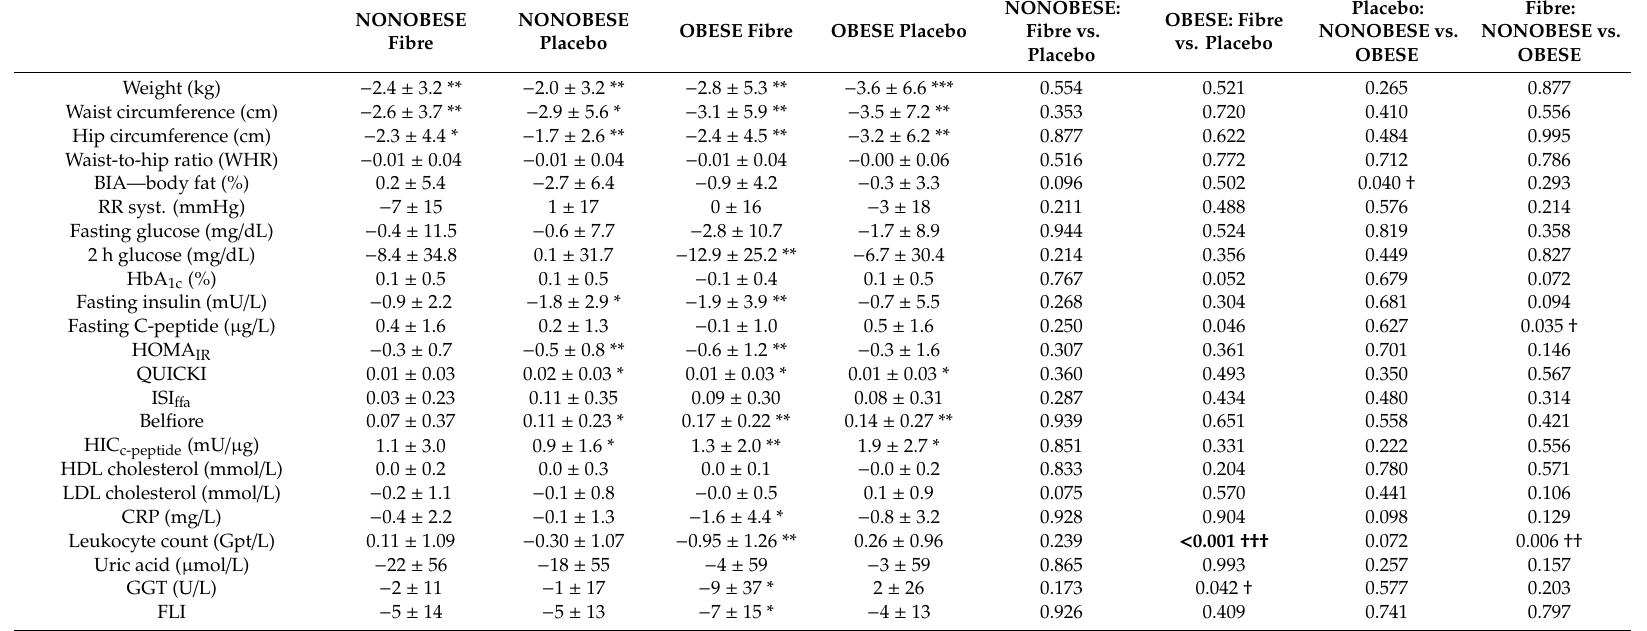
Table 3. Changes in anthropometric and metabolic parameters after 12